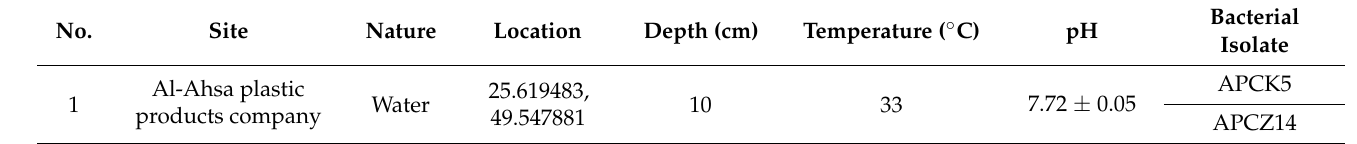
Table 1. Site of sampling, temperature, and pH values from which bacterial isolates were obtained.